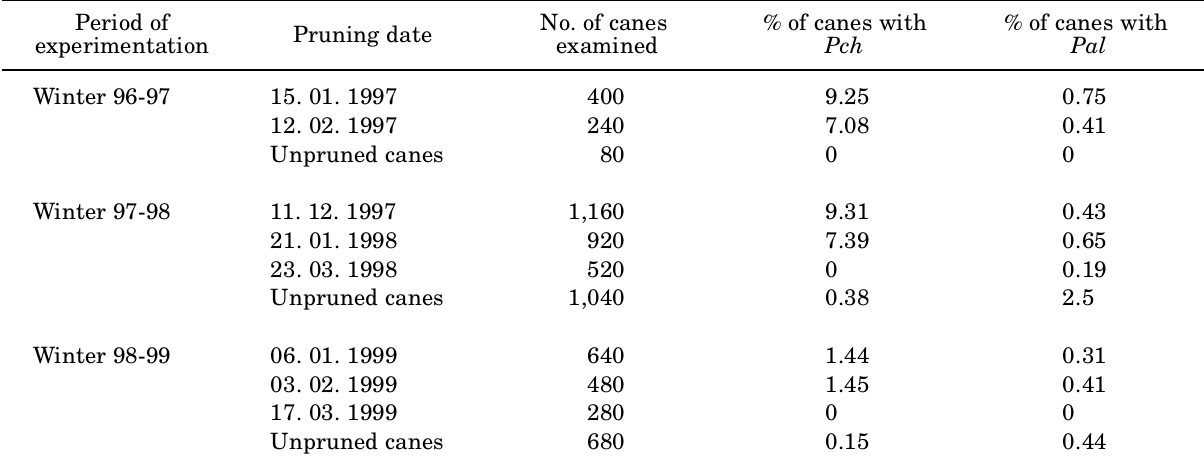
Table 1. Percentage of isolation of P. chlamydosporum ( Pch ) and P . aleophilum ( Pal ) from pruned and unpruned canes during three winters. Period of